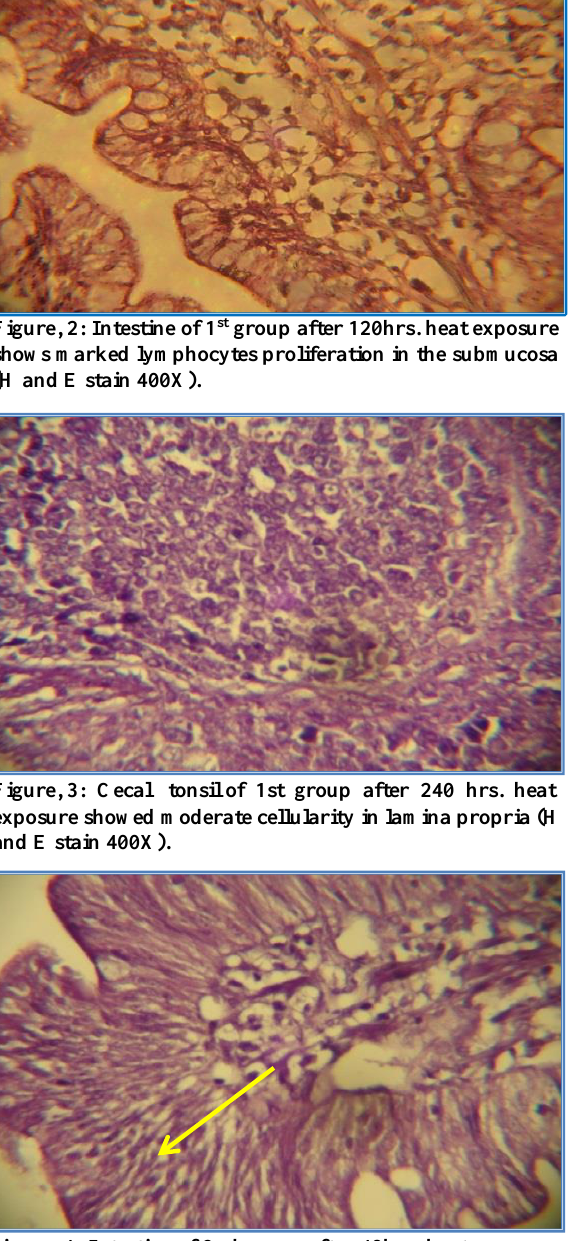
Figure, 4: Intestine of 2nd group after 48hrs. heat exposure showed mild cellularity of the lamina propria (H and E stain 400